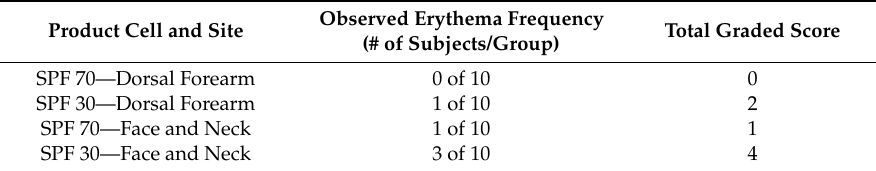
Table 3. Clinical sunburn grading based on a four-point